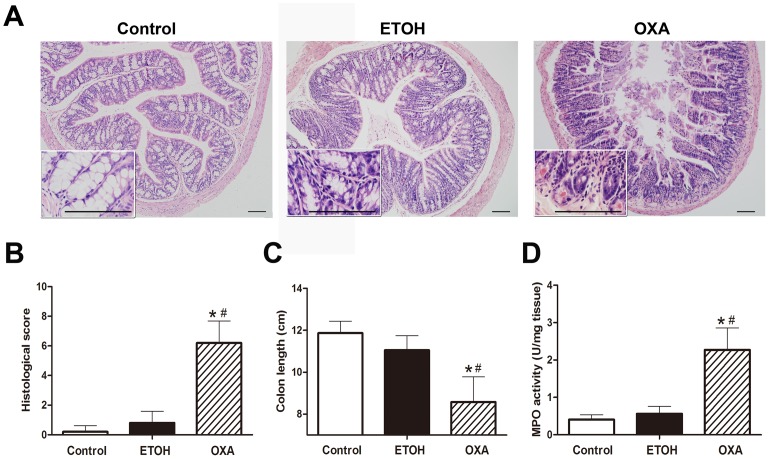
Changes in histological scores, colon length and MPO activity during oxazolone-induced colitis.
A. Tissue slices were inspected by a certified pathologist, and the inflammation severity of colonic tissues from surviving mice in each group was scored and documented. Cross-sections represent the transverse colon. Image magnifications are 100-fold and 400-fold. Scale bar, 100 µm. B. The histological scores were higher in the OXA mice during colitis. C. The colon length of the OXA mice was significantly shorter than the ETOH mice. D. The MPO activity was significantly increased in the OXA mice compared to the ETOH mice. n = 10 per group, *p<0.05 versus the control mice, and #
p<0.05 versus the ETOH mice.